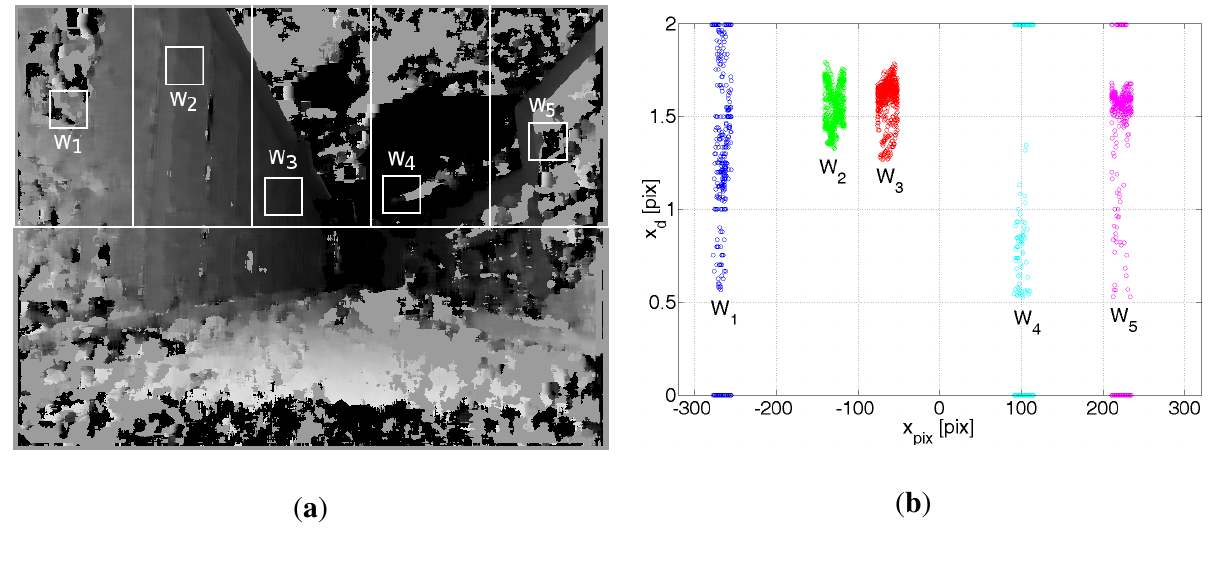
Figure 13. ( a ) An example of a disparity map K . Darker colours correspond to smaller ( j = 1 . . . 5) values of disparity, thus larger distances. Example windows for each region S j are denoted by W through W . One can see that for windows W and W the depth 1 5 2 3 map was determined correctly and these windows should be compared with corresponding windows in the L depth map. ( b ) The disparity values x for each window W as a function V d j of the x coordinate in the disparity picture. For W , W and W windows, the disparity pix 1 4 5 x changes from 0 pix to ≈ 2 pix which corresponds to distances ∞ to ≈ 16 m. These d windows should be rejected from further